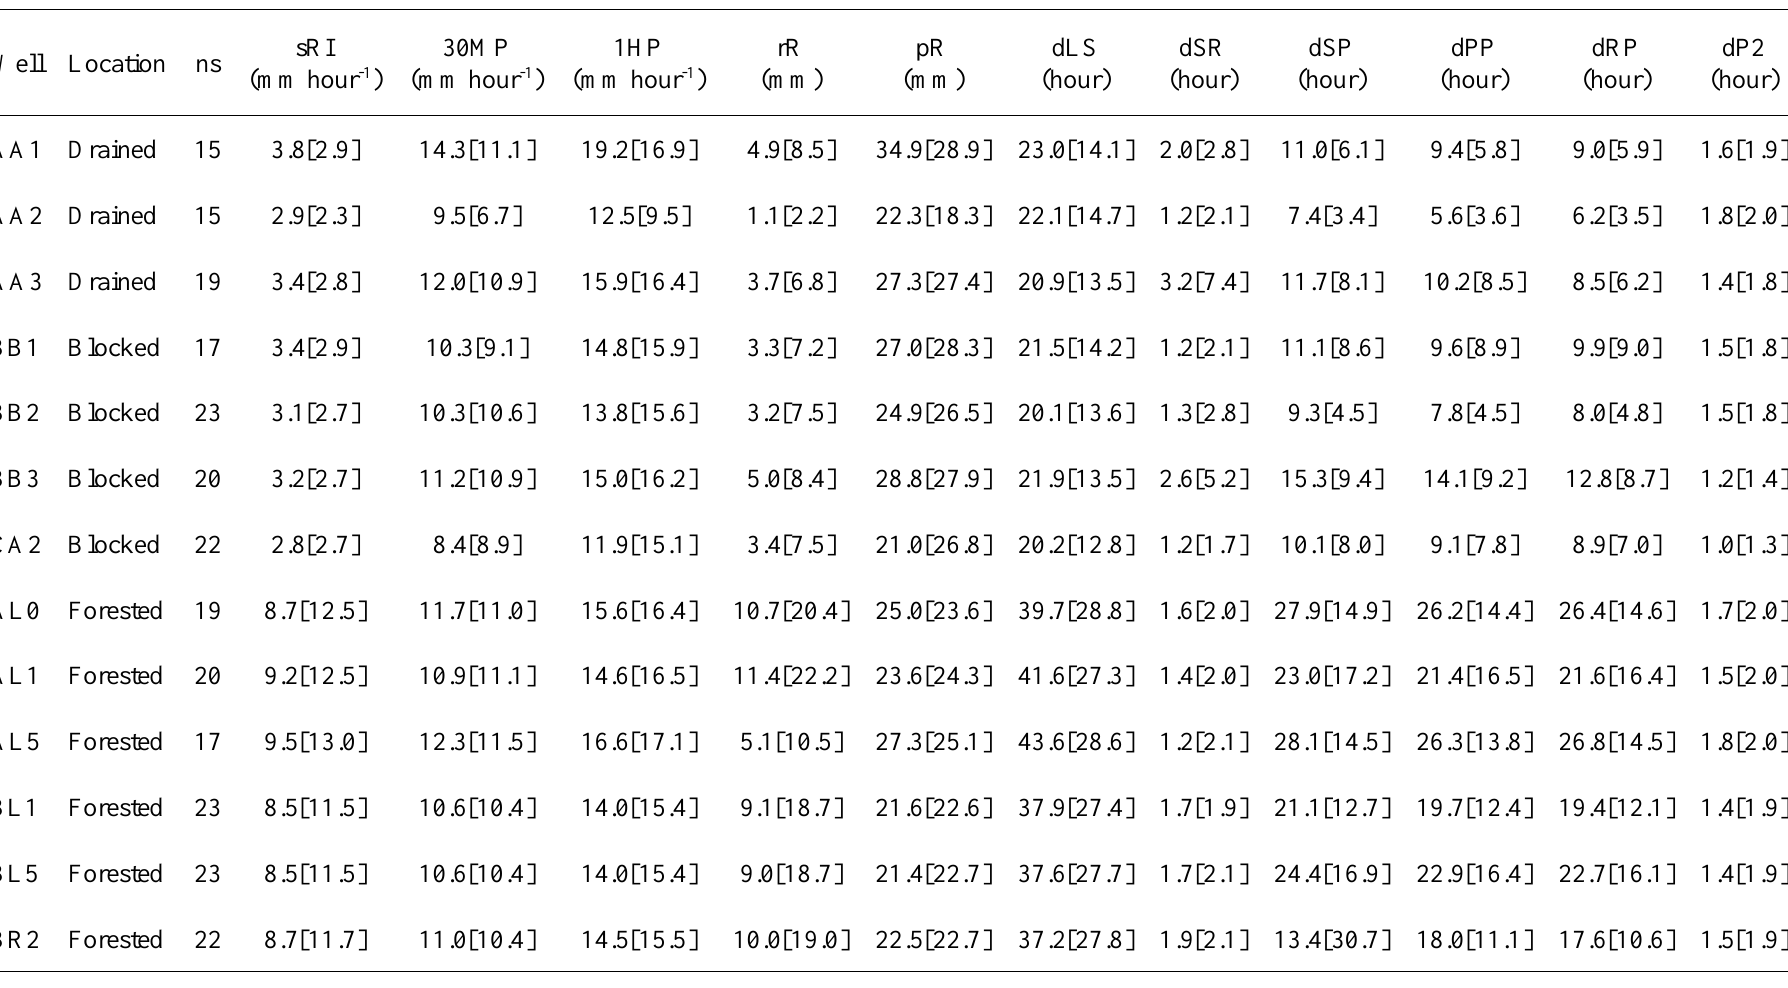
Table 2. Mean values of storm variables for each monitoring well during shallow water-table conditions. Standard deviations are in square brackets. The variable codes are as given in Table 1. Column ns contains the number of storms included in the